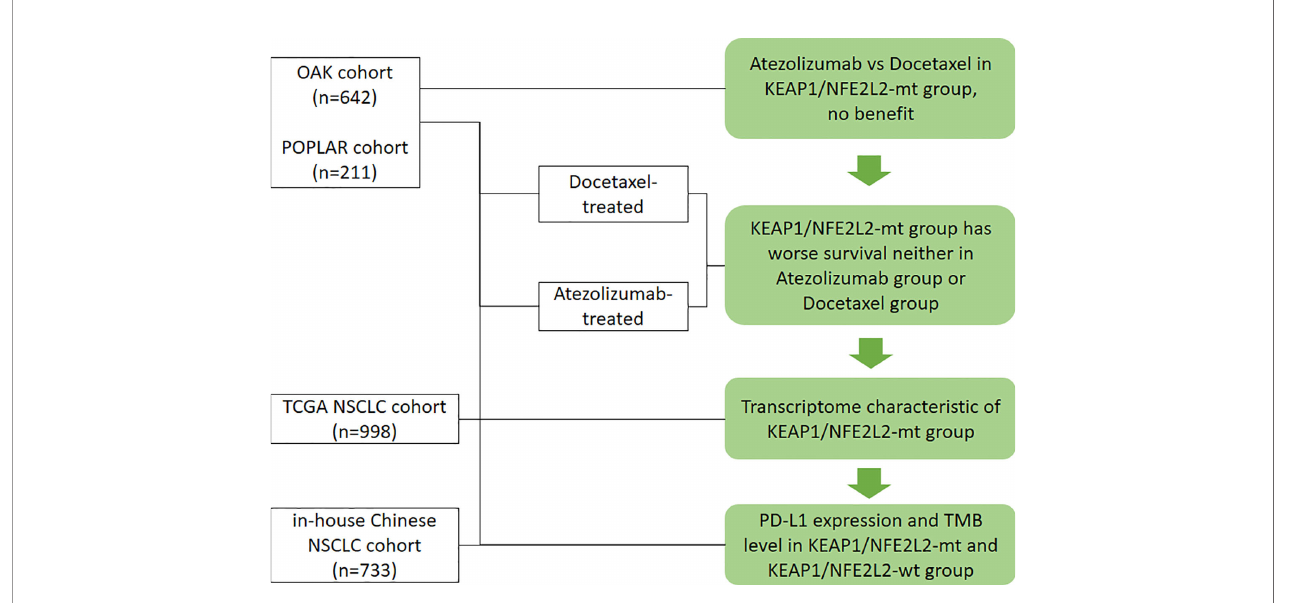
FIGURE 1 | Work fl ow of the study. Flow diagram illustrating the cohorts considered and the main purposes of the analytical